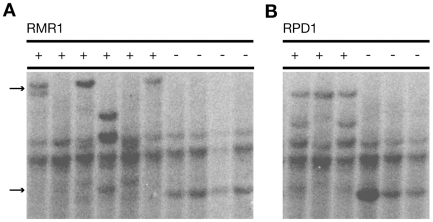
Southern blots of HinfI-digested genomic DNA hybridized with a radiolabeled Mu1 fragment.The upper arrow identifies high-molecular weight restriction fragments indicative of methylated Mu1 and the lower arrow identifies hypomethylated Mu1 fragments. (A) Blot for genomic DNAs isolated from rmr1-1 homozygotes (−) and heterozygous siblings (+). (B) Blot for genomic DNAs isolated from rpd1-1 (rmr6-1) homozygotes (−) and heterozygous siblings (+).